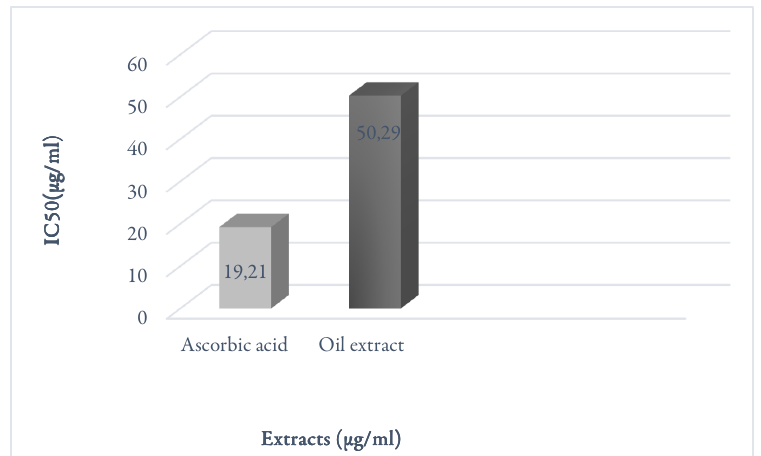
Figure 3. IC 50 values of ascorbic acid and oil